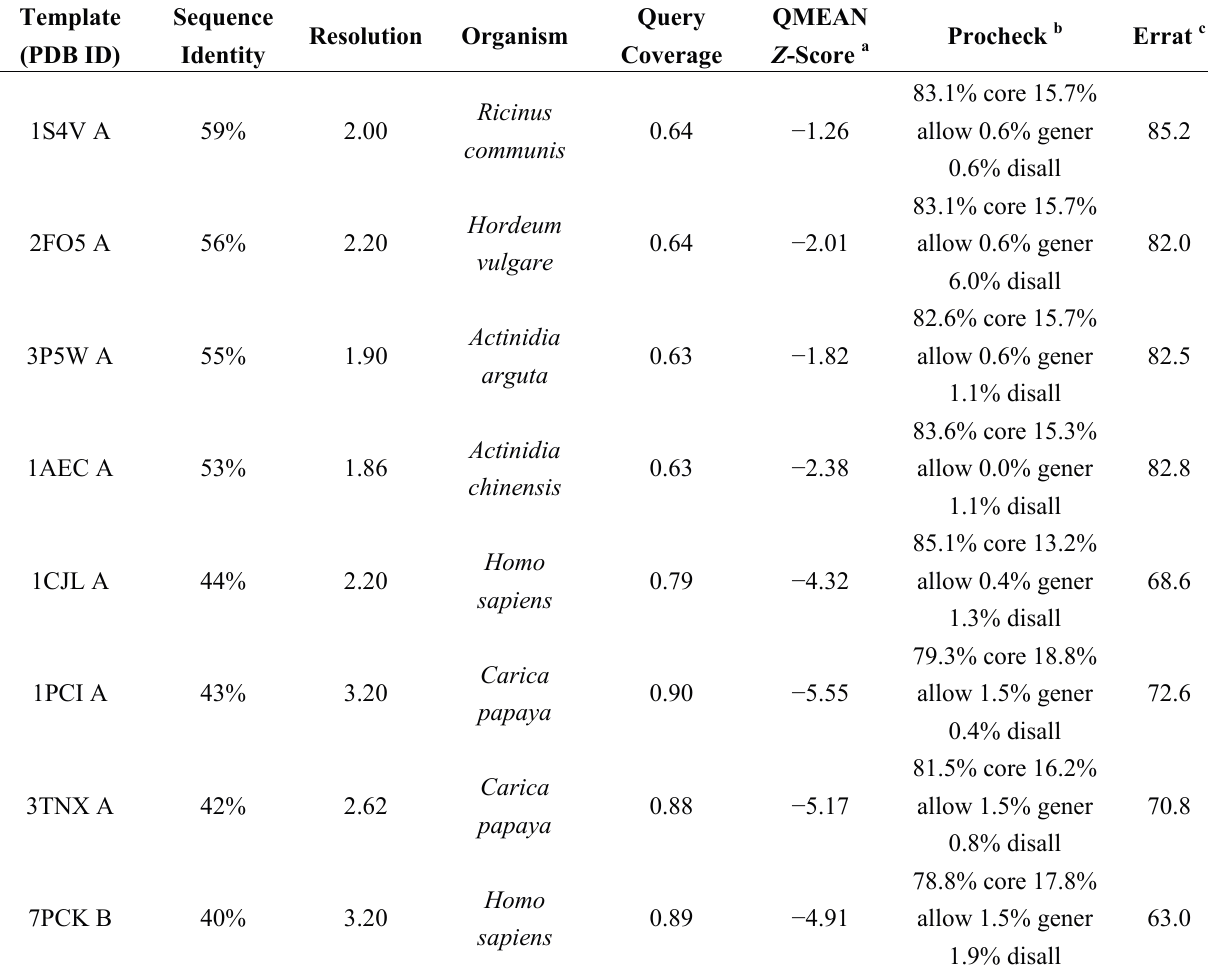
Table 1. The homology modeling results (made by Swiss model